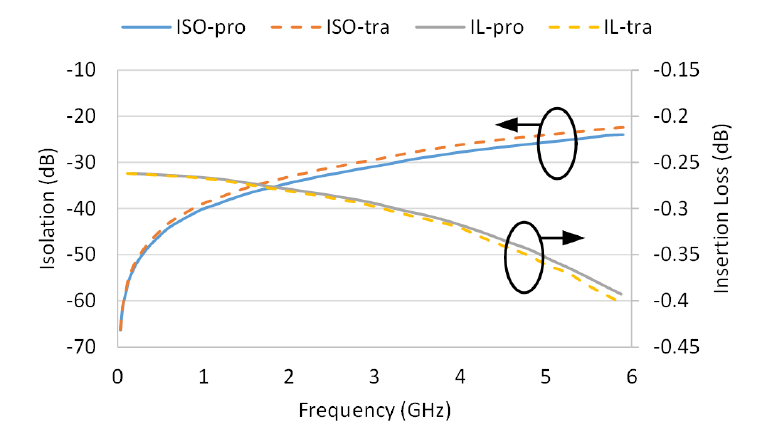
Figure 14. Post-layout simulation results of the RF switch with and without the proposed layout.